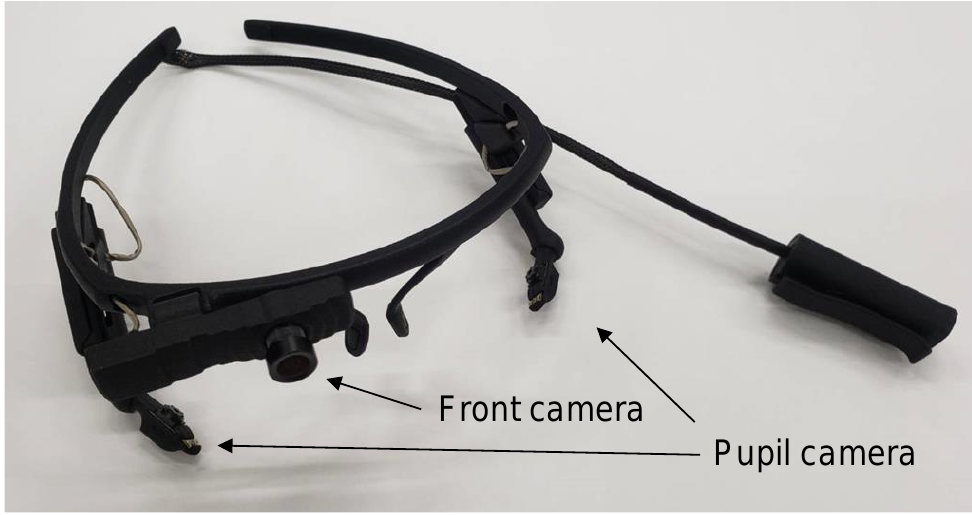
Figure 1. Wearable glasses for monitoring eye trails. The front camera captures frontal photographs, and the two-pupil cameras are used to track the pupils. The device is connected to a PC via a USB interface.